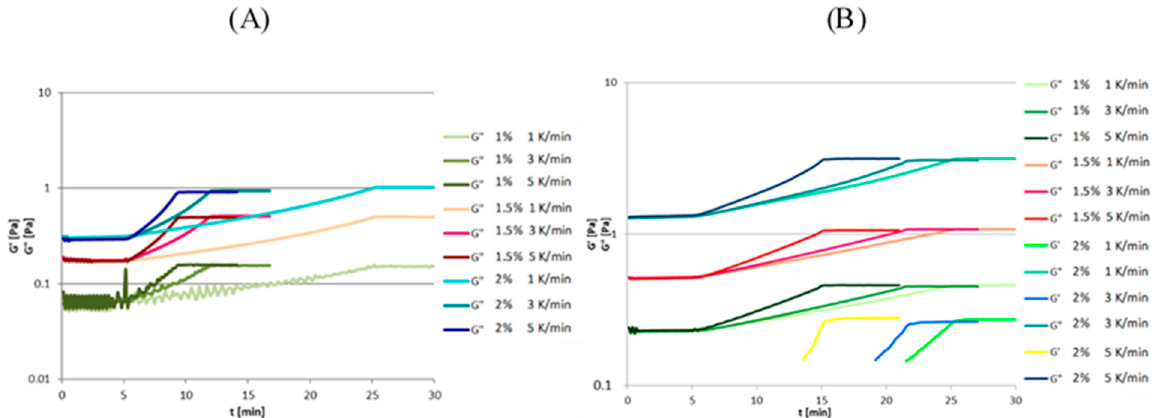
Figure 4. Gelatinization curves of high-methylated apple pectin ( A ) and sodium alginate ( B ) with different concentrations and cooling rates